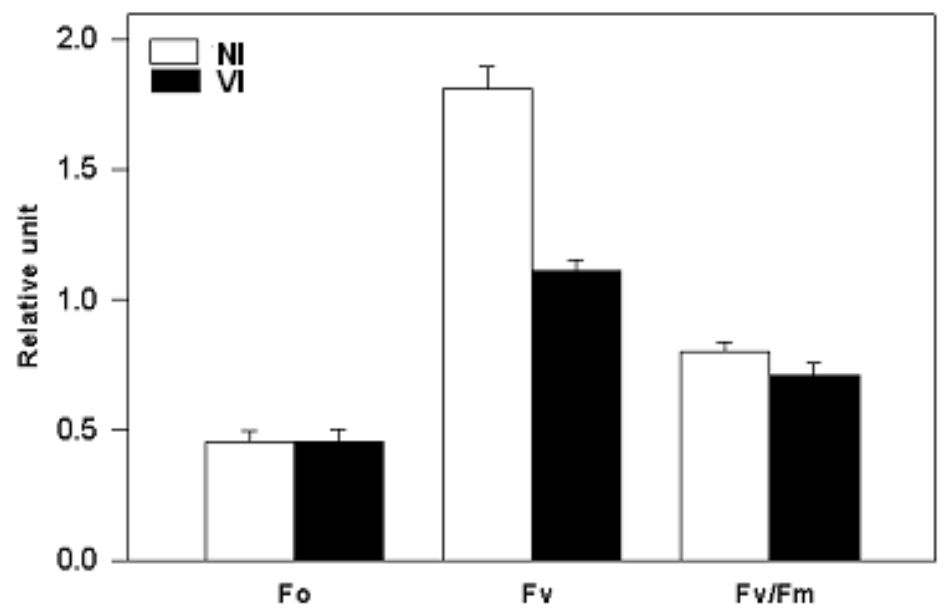
Fig. 1. Changes in the relative levels of fluorescence emitted as minimal fluorescence ( F and the ratio of variable to maximum fluorescence ( F leaves (means ±SE; n =5).